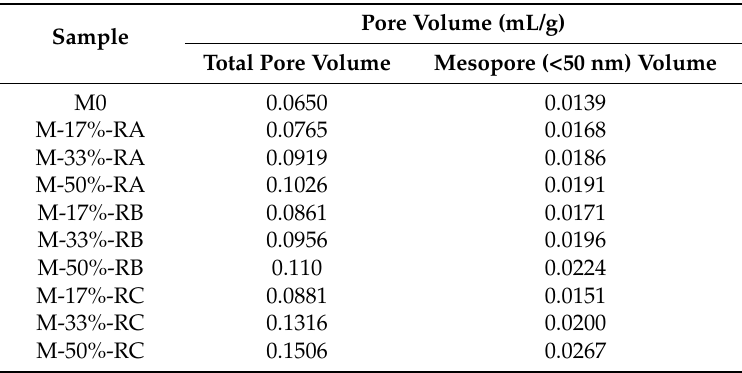
Table 4. Total pore volume and capillary pore volume of CRMs.